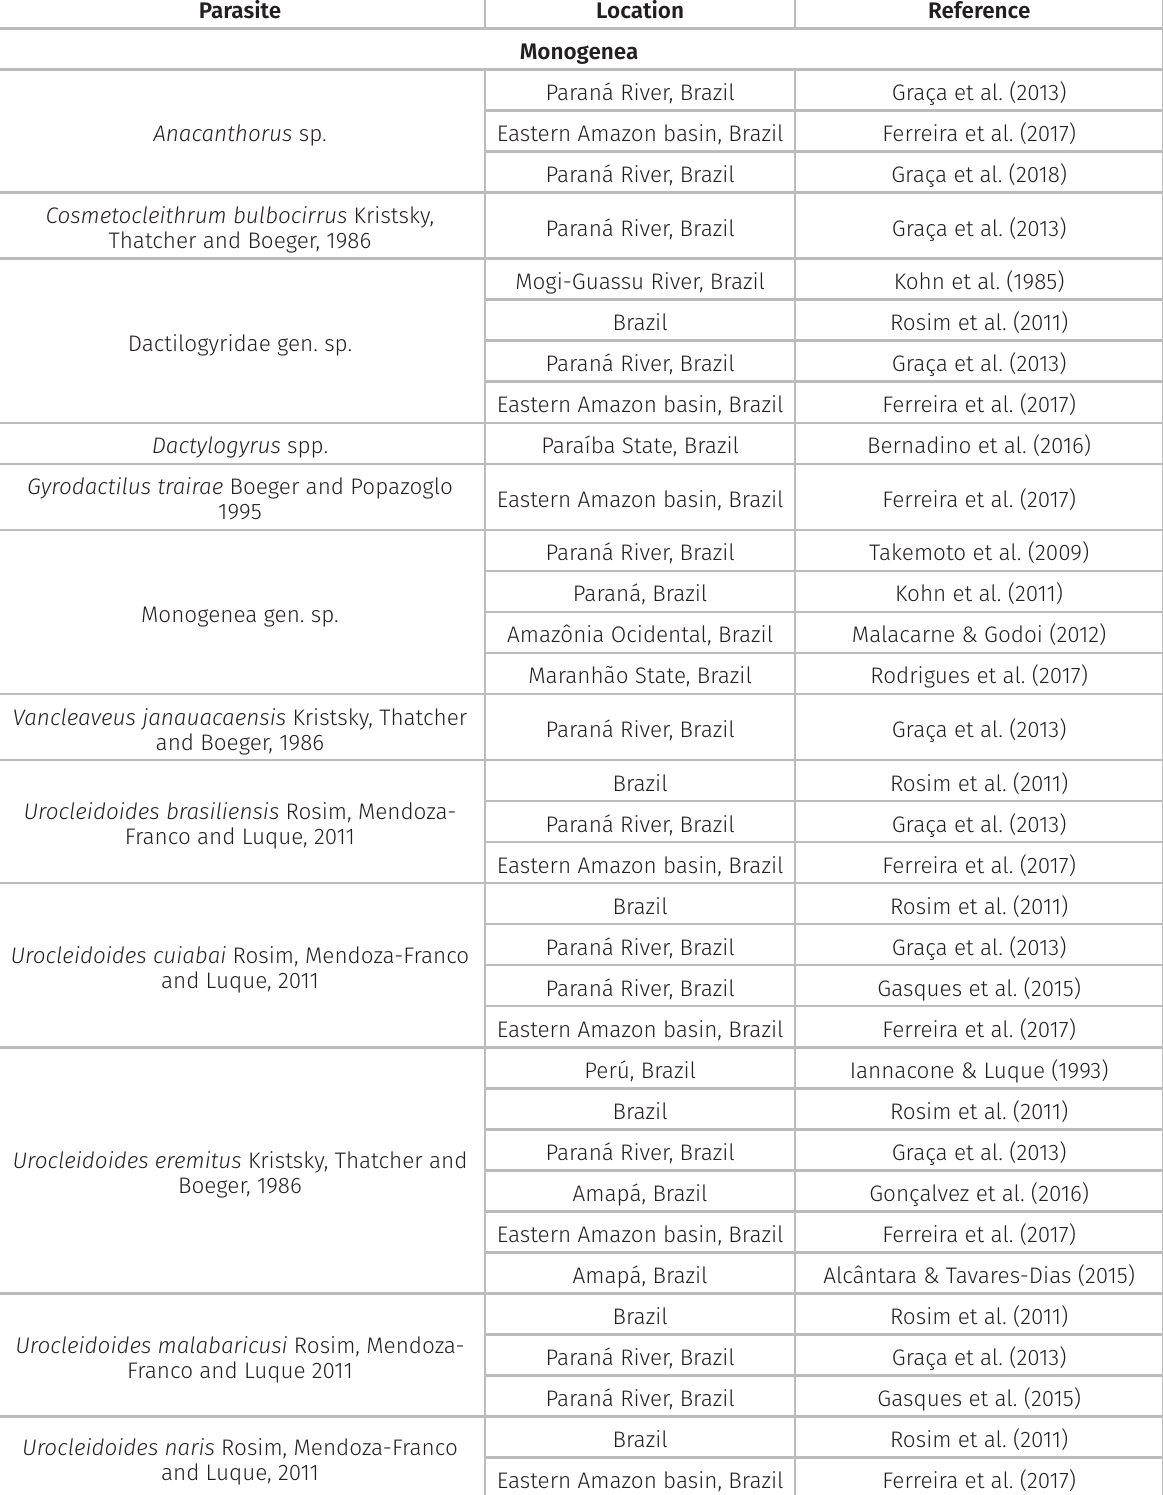
Table I. Records of parasites identified in Hoplias malabaricus (Bloch, 1794) specimens from different locations in